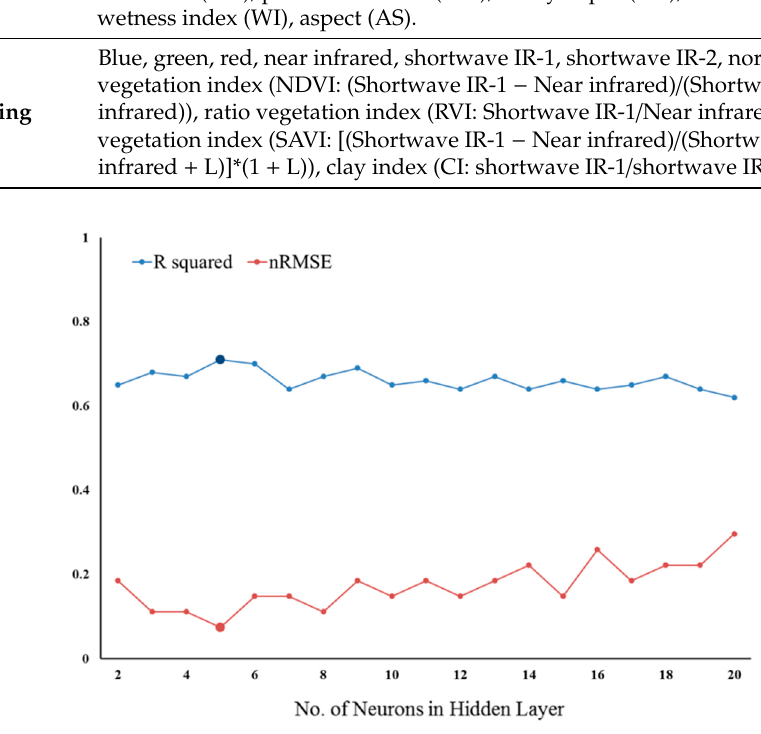
Figure 5. nRMSE and R 2 values for different number of neurons in the hidden layer of ANN used to predict soil erosion for the study watershed.